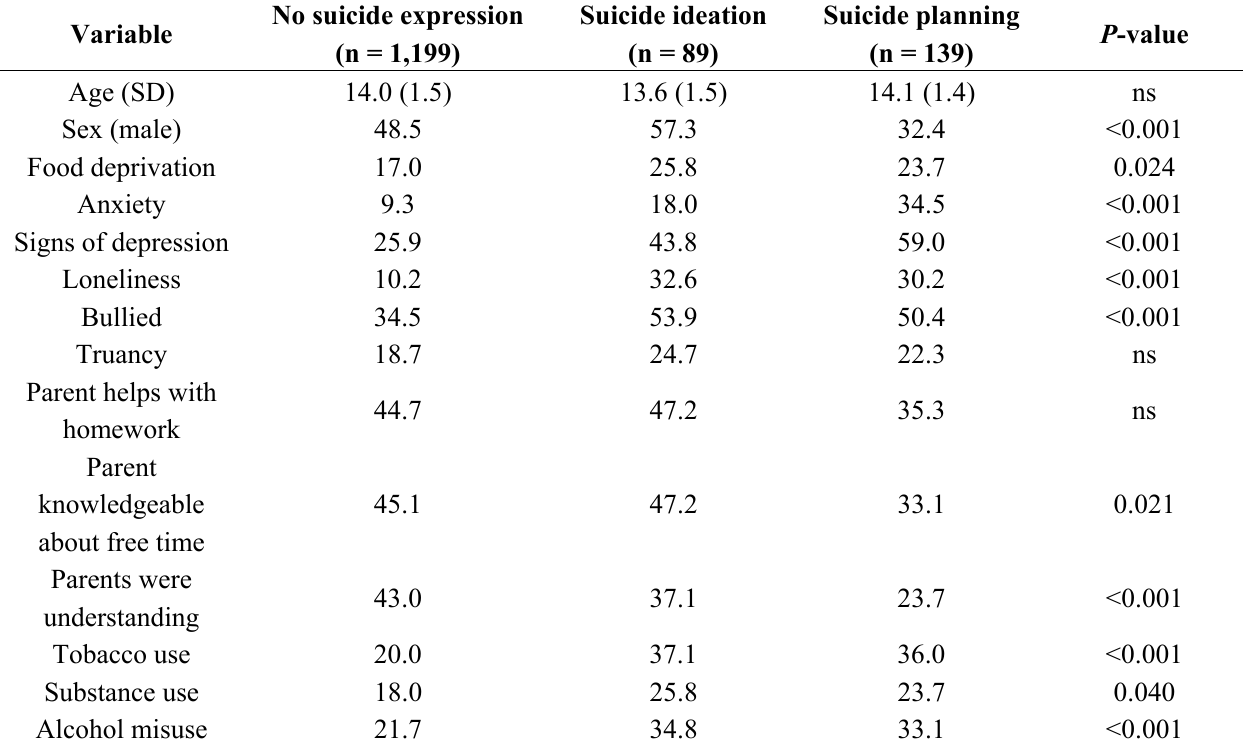
Table 1. Distribution of selected factors according to categories of suicide expression among school-attending adolescents in the